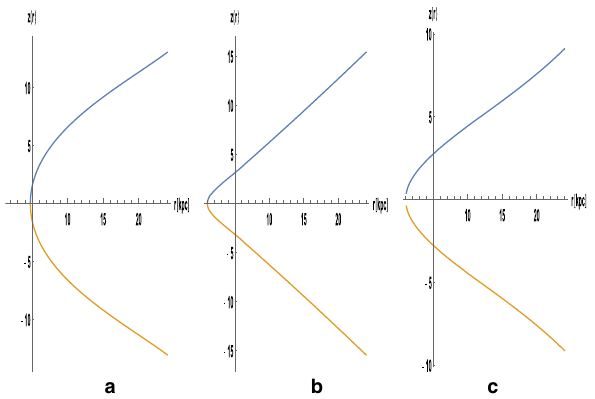
Fig. 7 Embedding diagram for the wormhole at the centre bulge with η = 0 . 003 for a NFW profile : r = 1 . 7 kpc , b Pseudo-Isothermal th profile : r th = 1 kpc , c URC profile : r th = 1 . 1 kpc